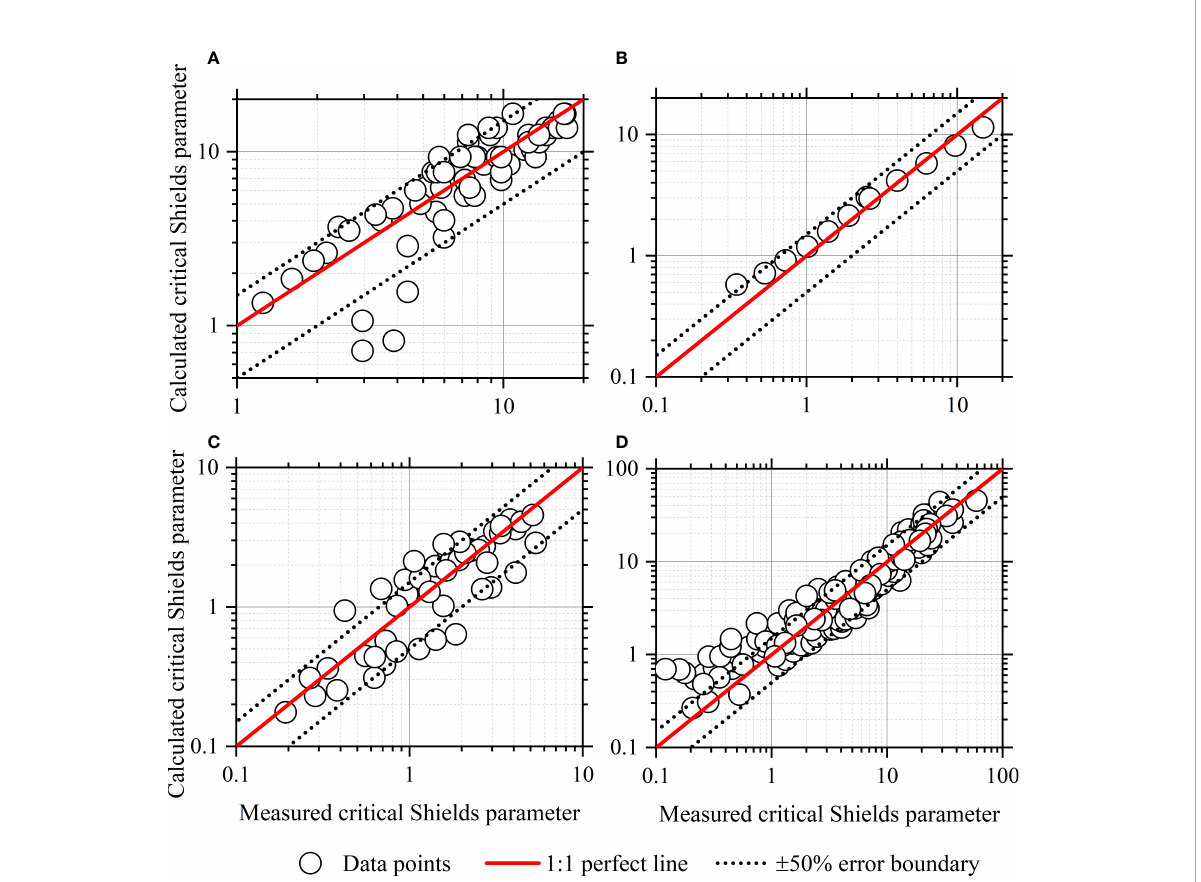
FIGURE 7 The calculated versus measured critical Shields parameters in the datasets of (A) kaolinite, (B) quartz, (C) lake and pond mud and (D) coastal